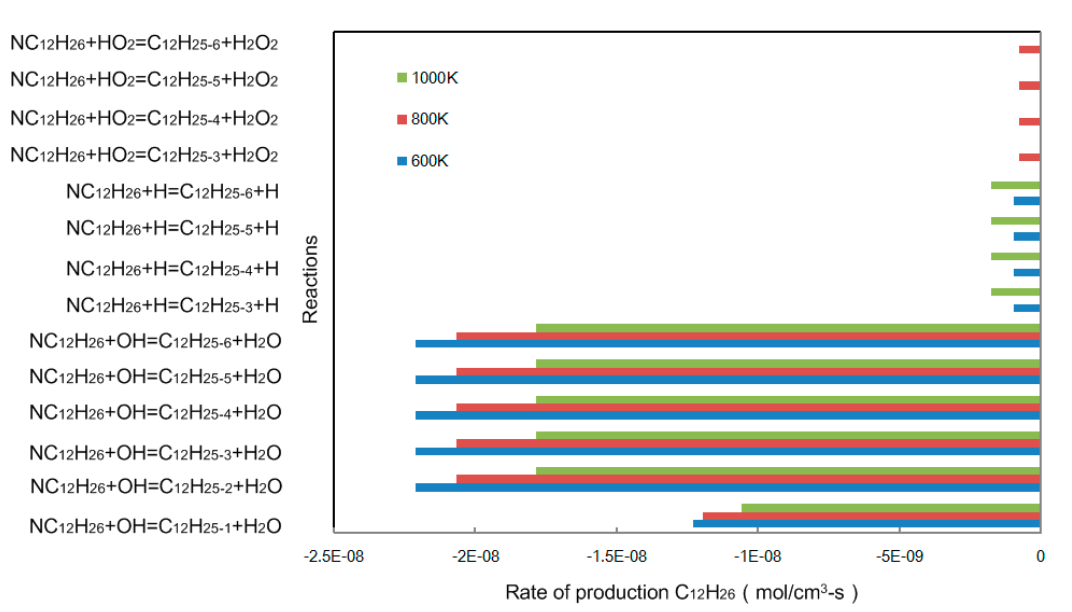
Figure 3. Rate of production C 12 H 26 in a perfectly stirred reactor (PSR) at P=0.1MPa,